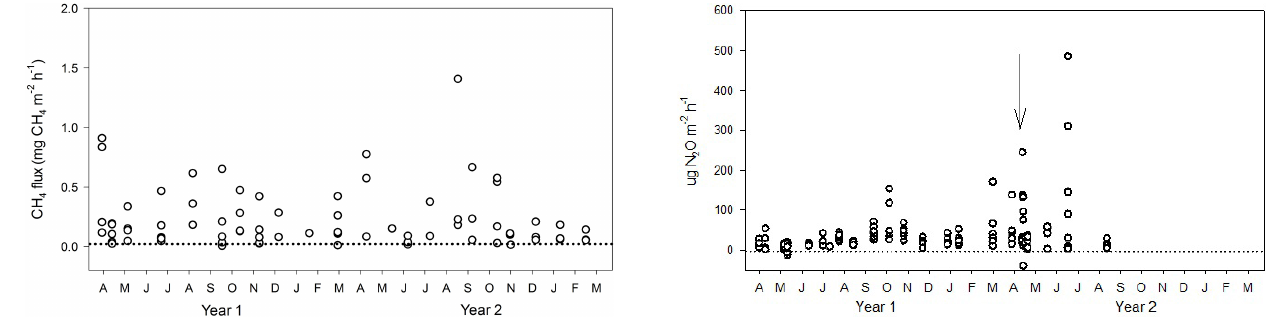
Figure 9. Measured N 2 O fluxes (µgN 2 Om − 2 h − 1 ) at Site B. The arrow represents a fertilisation event (25kgNha − 1